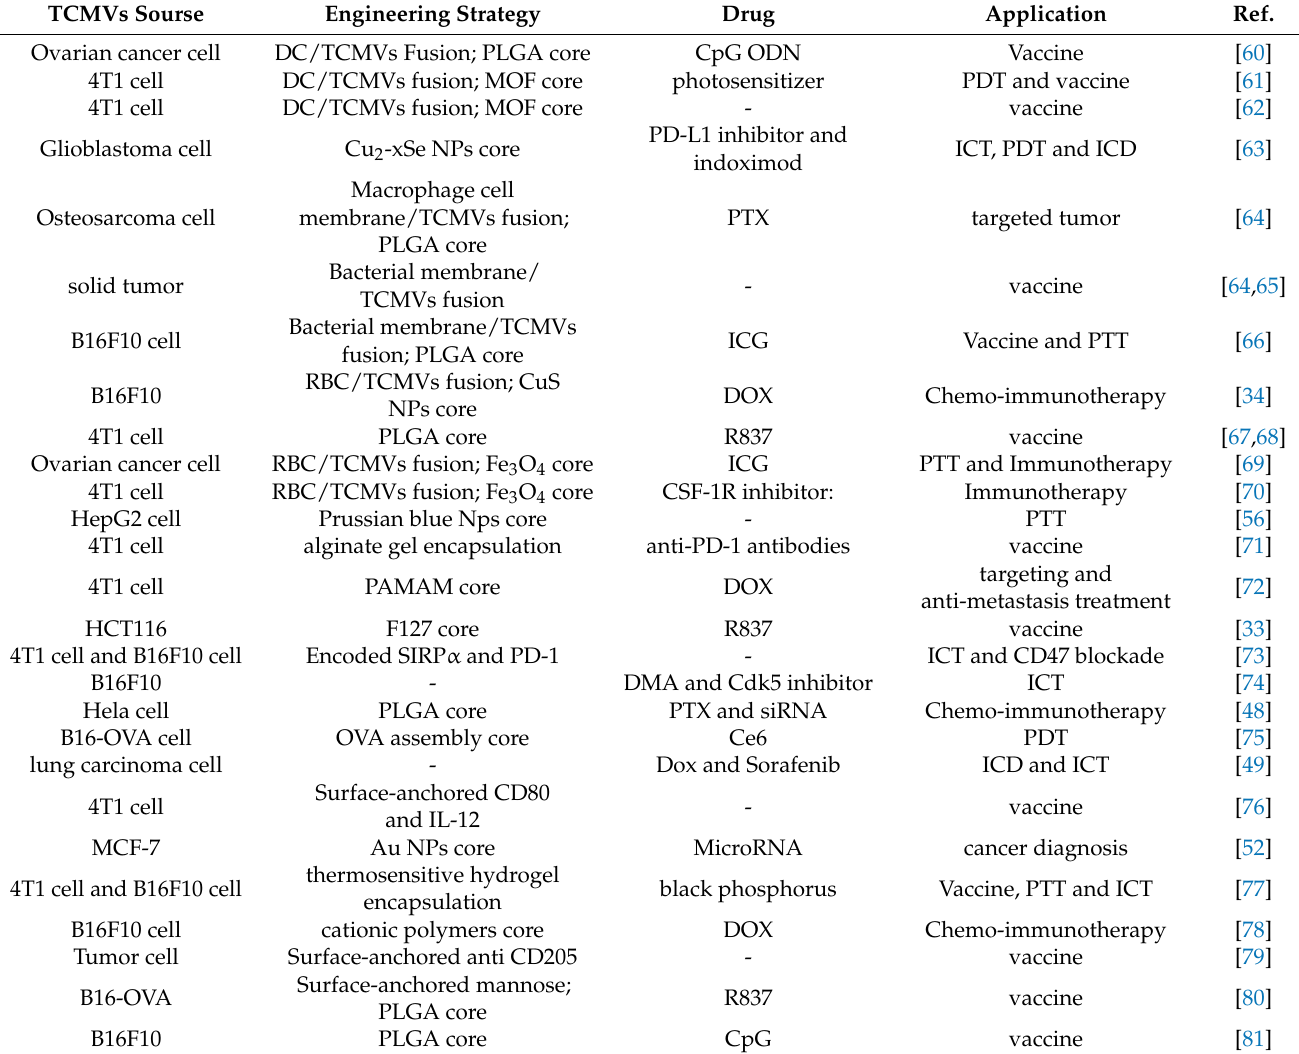
Table 1. Representative applications of TCMVS in tumor